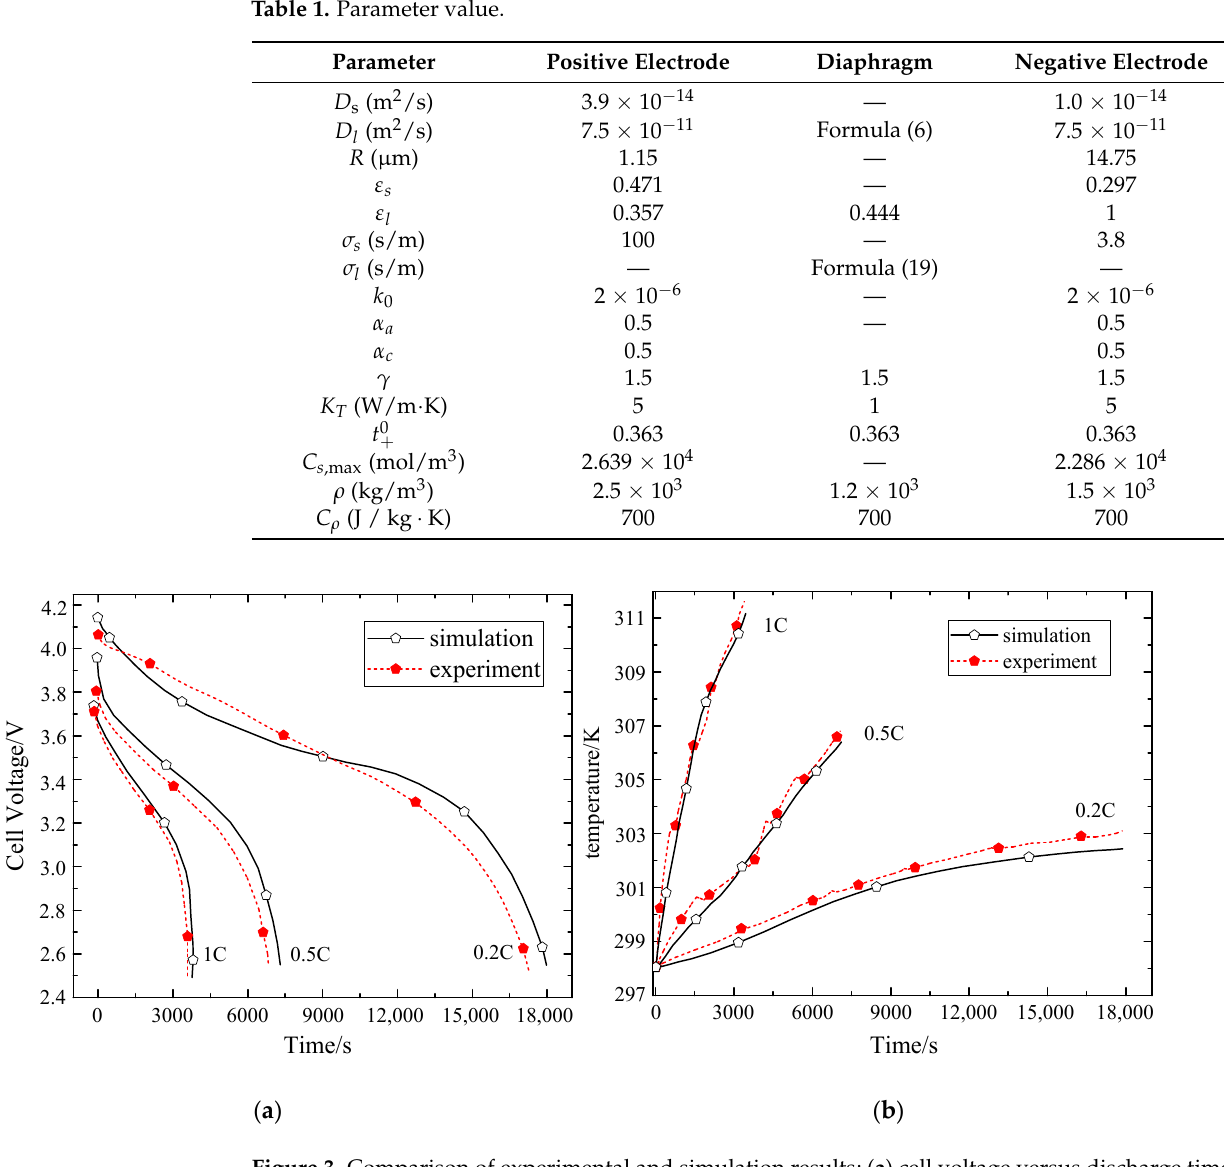
Table 1. Parameter value.